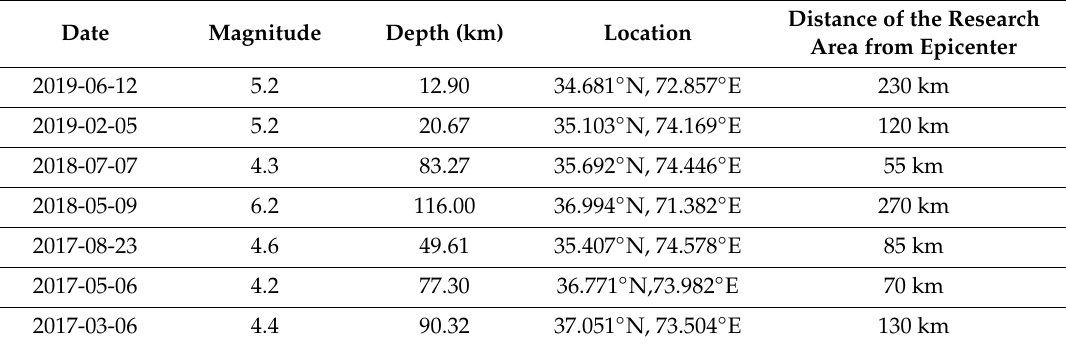
Figure 9. Khai landslide. (a) The LOS displacement rates in the Khai landslide as superimposed on Google Earth map for perspective view; (b) Displacement time series for representative pixels, for points a and b. Table1.